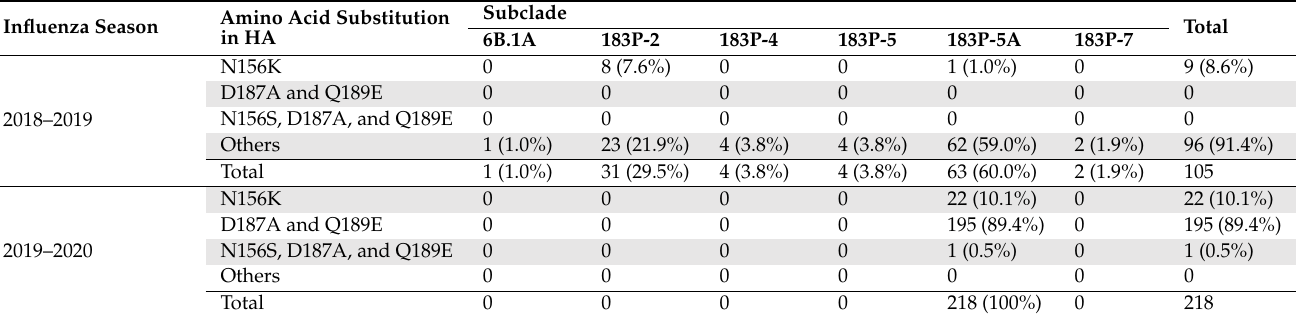
Table 1. Phylogenetic classification based on the HA of A(H1N1)pdm09 viruses isolated during